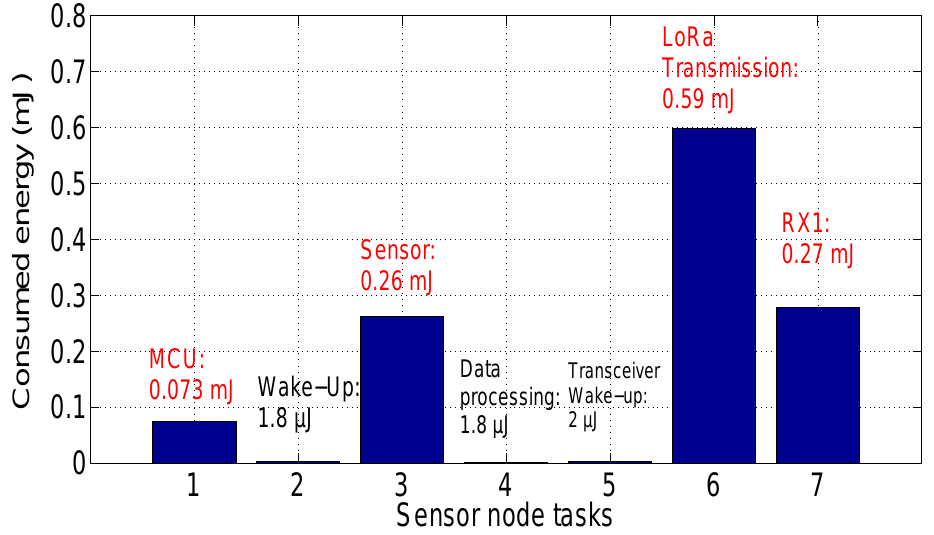
Figure 17. Energy consumption of sensor node: Scenario 2.